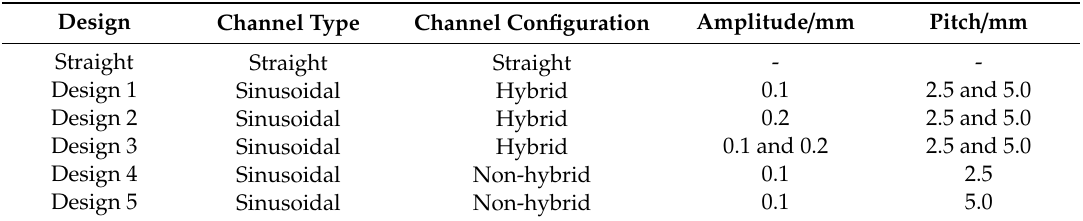
Table 1. Geometric dimension of the CFD model with the same channel length and bend radius of 25 mm and 1.0 mm, respectively.